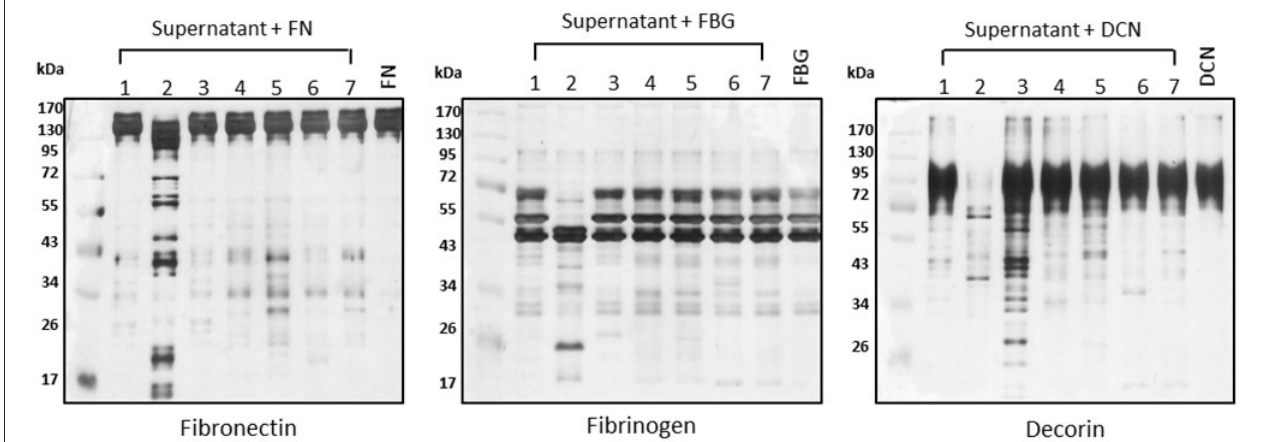
FIGURE 4 | Proteolytic activity correlates with virulence. Supernatants of (1) L. biflexa serovar Patoc strain Patoc I, (2) L. interrogans serovar Kennewicki strain Fromm (LPF), (3) L. biflexa serovar Andamana strain CH11, (4) L. interrogans serovar Copenhageni strain 10A, (5) L. interrogans serovar Pomona strain Pomona, (6) L. kirshneri serovar Cynopteri strain 3522C, (7) L. noguchi serovar Panama CZ 214 (0.5 µ g of total secreted proteins) were incubated with plasma fibronectin (5 µ g), fibrinogen (15 µ g), and decorin (2 µ g) for 18h h at 37 ◦ C. Cleavage products were analyzed by SDS- polyacrylamide gel under reducing conditions. Gels were silver stained. FN, plasma fibronectin; FBG, fibrinogen; DCN, decorin. Lane 8: controls (purified substrates).